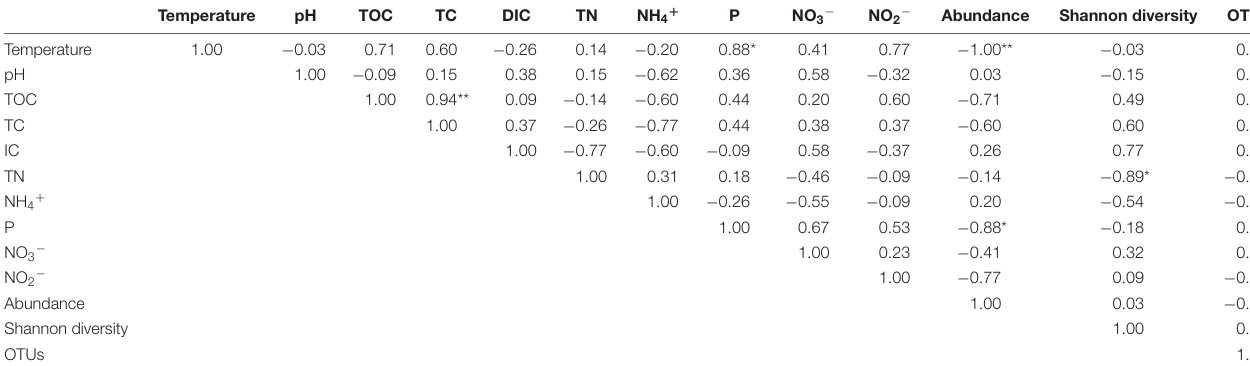
TABLE 3 | Spearman rank correlation analysis of environmental factors with the abundance and diversity of anammox bacterial community in Conghua hot spring. Temperature Shannon diversity Temperature